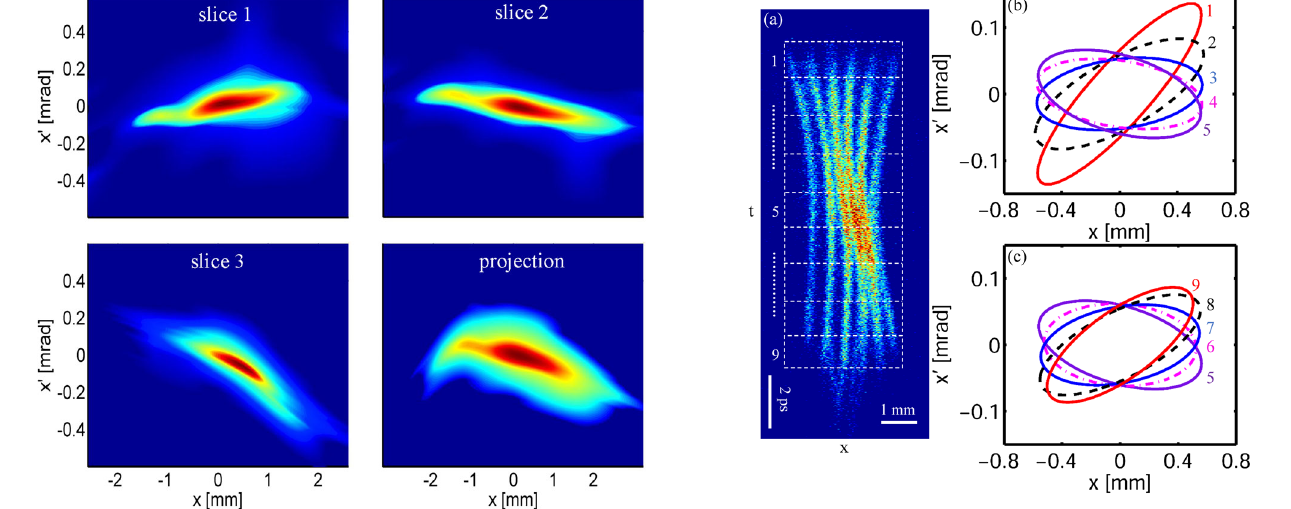
FIG. 6. Reconstructed phase space distributions for the three representative slices and the whole beam with the gap of the downstream CS set at 3.2 mm.